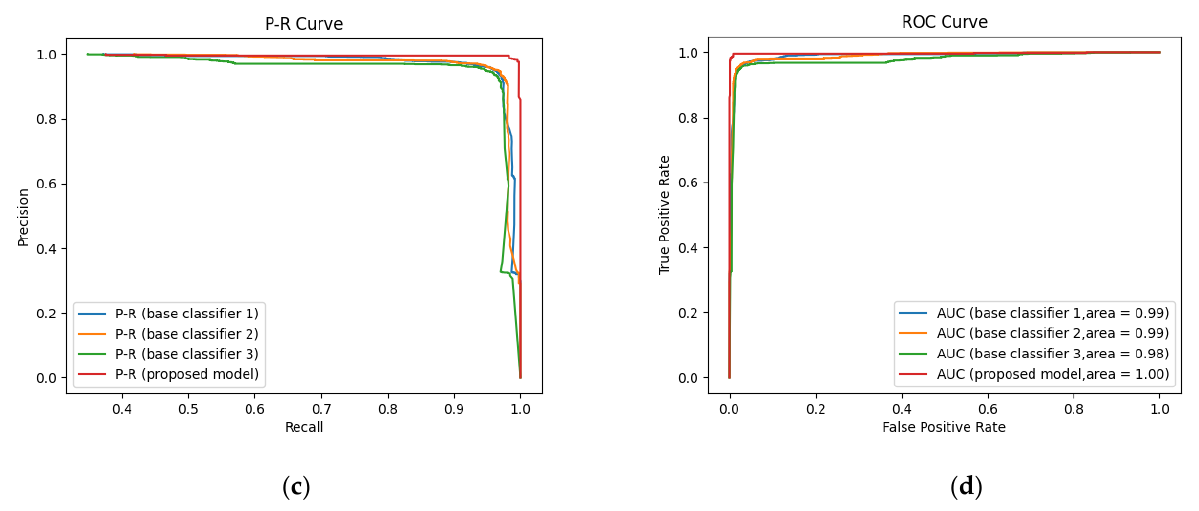
Figure 7. Three-class correlation curves for the three base classifiers and the proposed model (CovidX-LwNet). ( a ) train loss, ( b ) train accuracy, ( c ) P-R, ( d ) ROC.